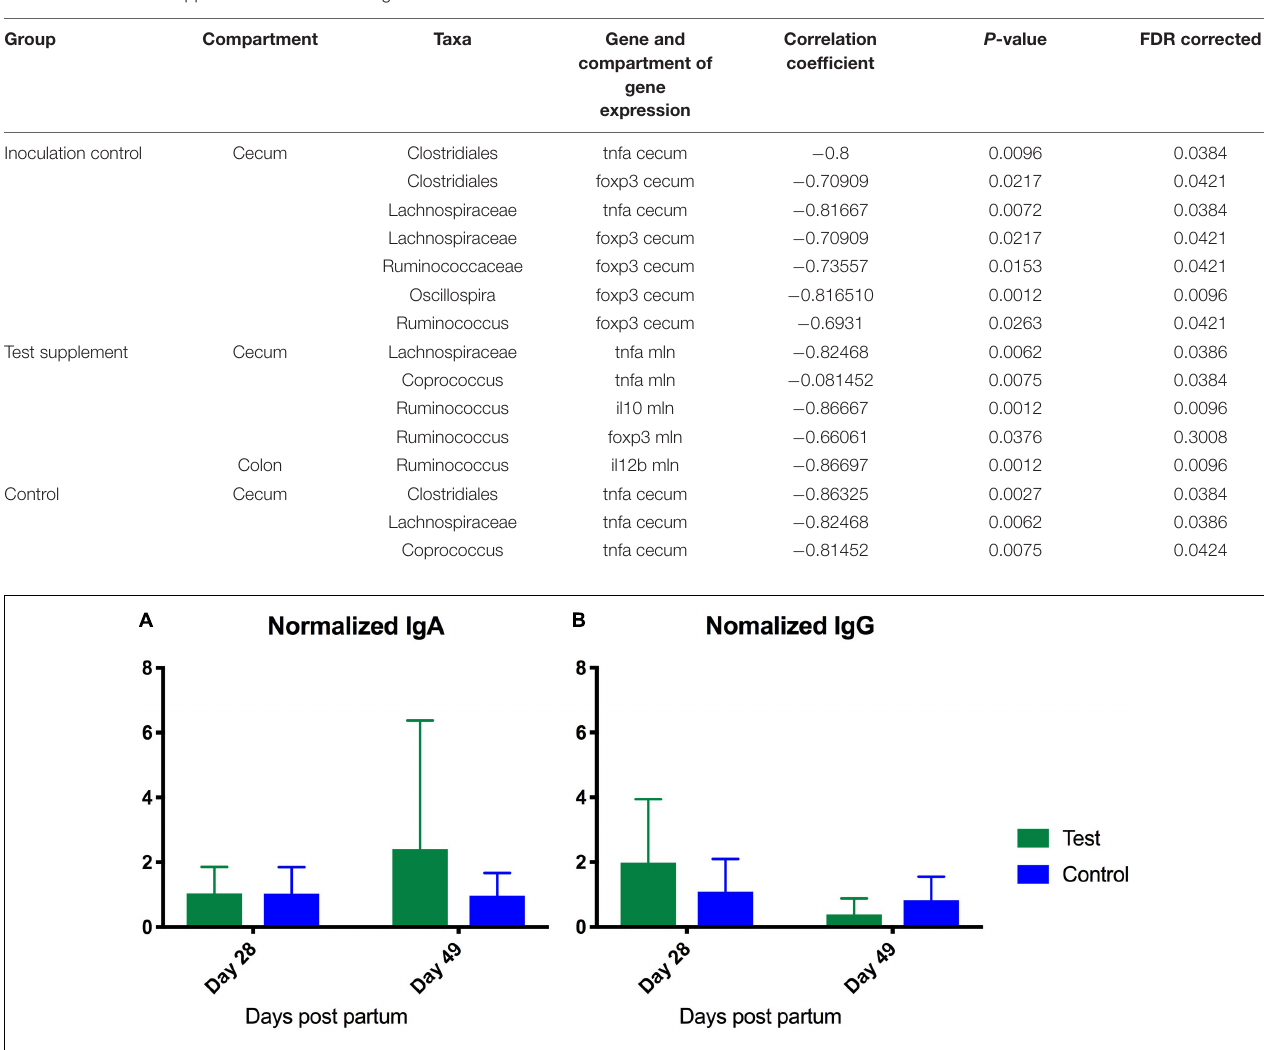
FIGURE 7 | Enzyme-linked immunosorbent assay analysis of serum content of IgA (A) and IgG (B) from foals fed either a test supplement enriched with oligosaccharides or a control diet. X -axis shows levels (ng/mL) measured at Day 28 and 49 normalized to levels measured on Day 7 as baseline. A repeated measures test investigating the development from day 7 to 40 revealed no significant